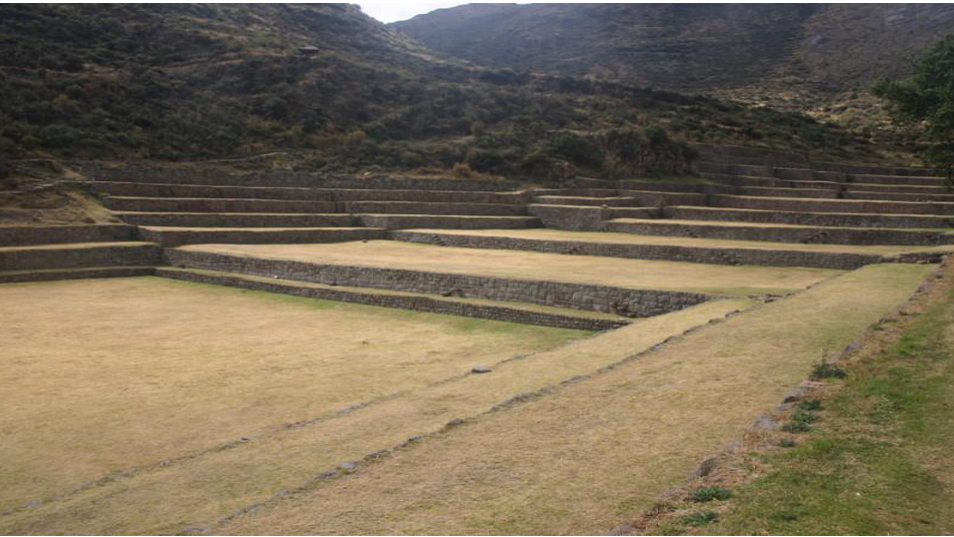
Figure 2. View of the thirteen agricultural terraces at Tipon. The terraces are located to the right of the Plaza Ceremonial shown in Figure 1. (Photo by C. Ortloff).